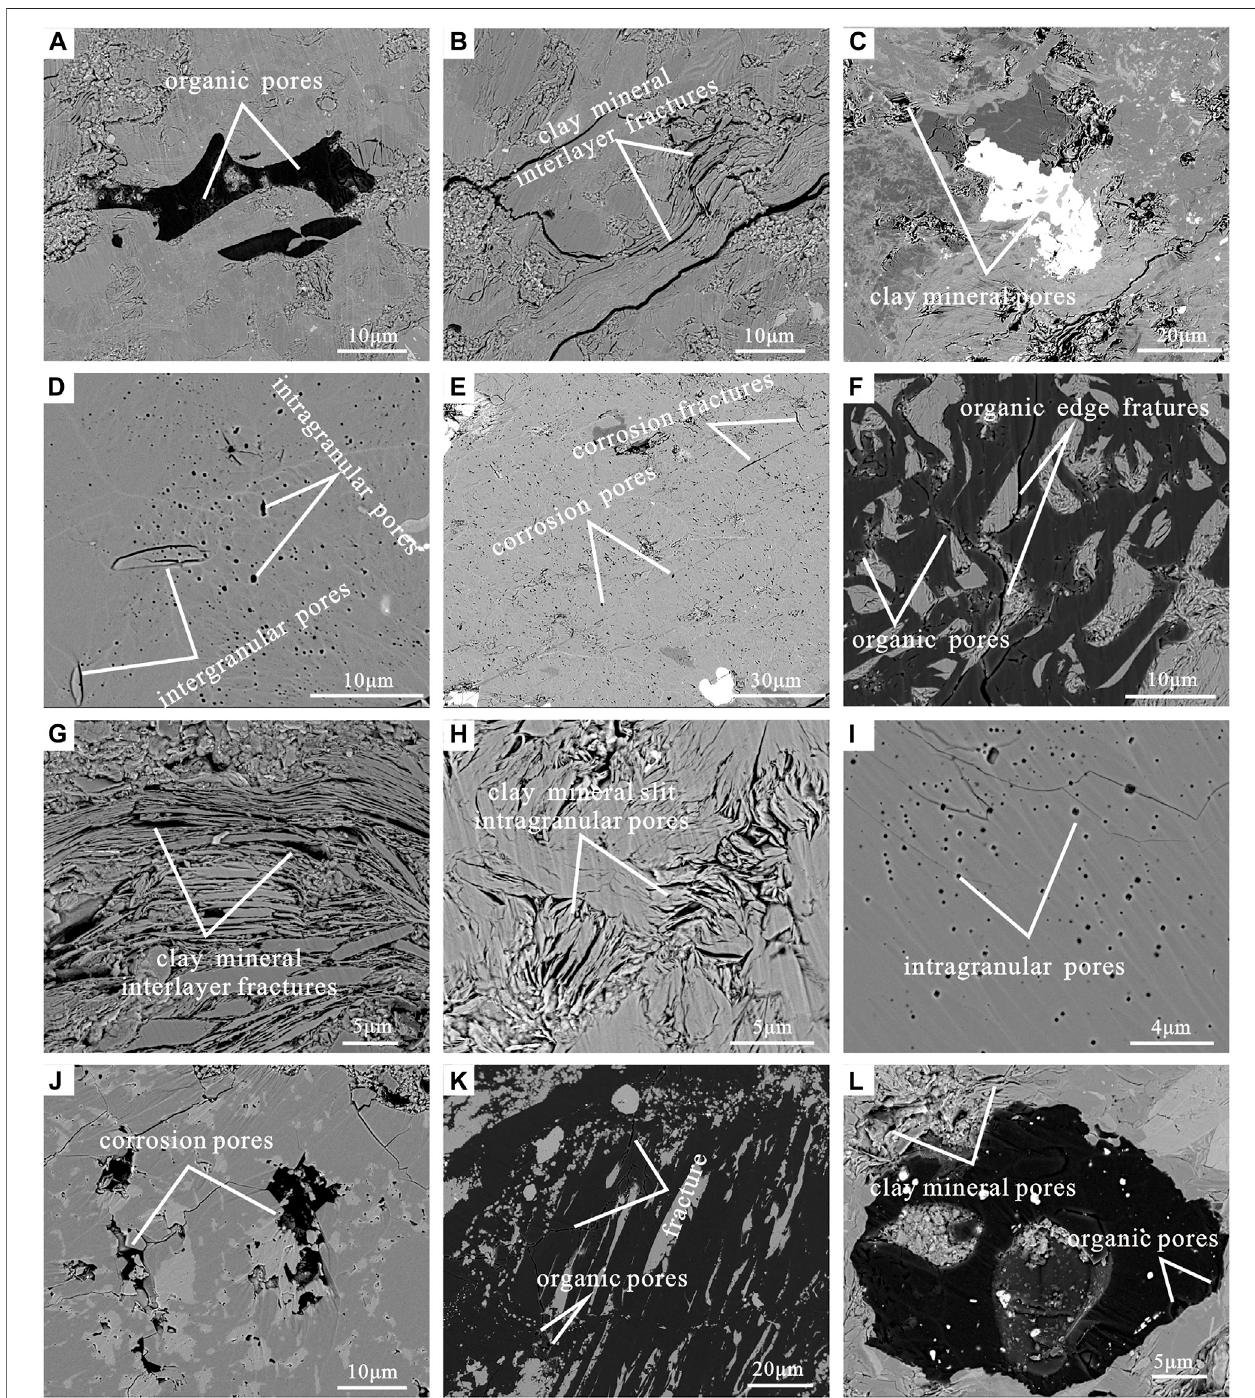
FIGURE3| DevelopmentcharacteristicsofdifferenttypesofporesofthecoalmeasuresamplescollectedfromtheM5wellintheShan2Member.Notes: (A) M5-1, Organic pores in shale; (B) M5-1 and (C) M5-14, Interlayer micro-fractures and pores in clay minerals in shale; (D) M5-14 Intragranular and intergranular pores in shale; (E) M5-13, Feldspar dissolution pores and micro-fractures in shale; (F) M5-16, Organic pores and organic edge micro-fractures in tight sandstones; (G) M5-7 and (H) M5-9, Interlayer micro-fractures and micropores in clay minerals in tight sandstone; (I) M5-7, Quartz intragranular pores in tight sandstone; (J) M5-4, Feldspar dissolution pores in tight sandstone; (K) M5-3, Organic pores and micro-fractures developed in coal; (L) M5-11, Clay mineral pores in coal.